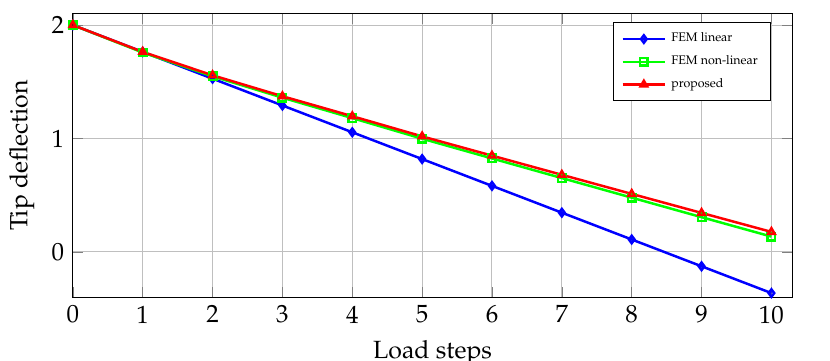
Figure 4. 3d cantilever beam.